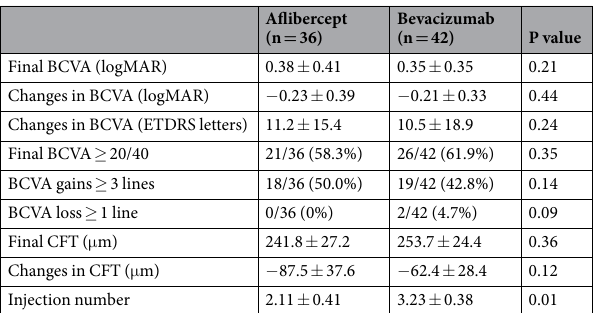
Table 2. Comparison of clinical data after 12-month treatment of intravitreal aflibercept or and bevacizumab for myopic choroidal neovascularization. BCVA: best-corrected visual acuity CFT: central foveal thickness.